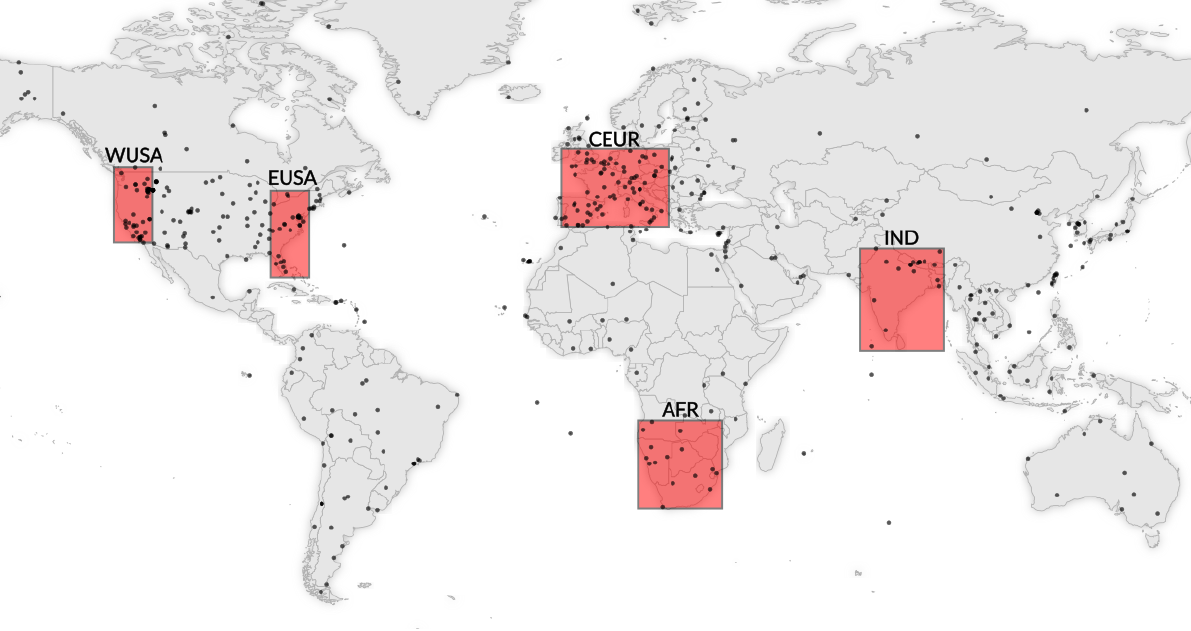
Figure 2. Regions of interest. Black dots indicate locations of AERONET